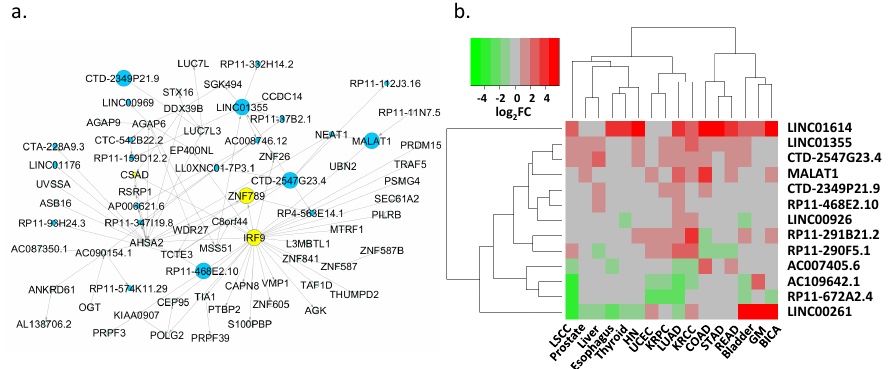
Figure 4. Key regulatory lncRNAs. ( a ) Network 10 consists of several lung cancer-related lncRNAs, such as MALAT1 and NEA1. The blue-colored nodes represent lncRNA transcripts. ( b ) The expression alterations (log 2 (FC)) of 13 key lncRNAs in the 16 solid tissue cancer types. Red denotes over-expression while green represents under-expression of the lncRNAs in cancers. Grey refers to an insignificant gene expression